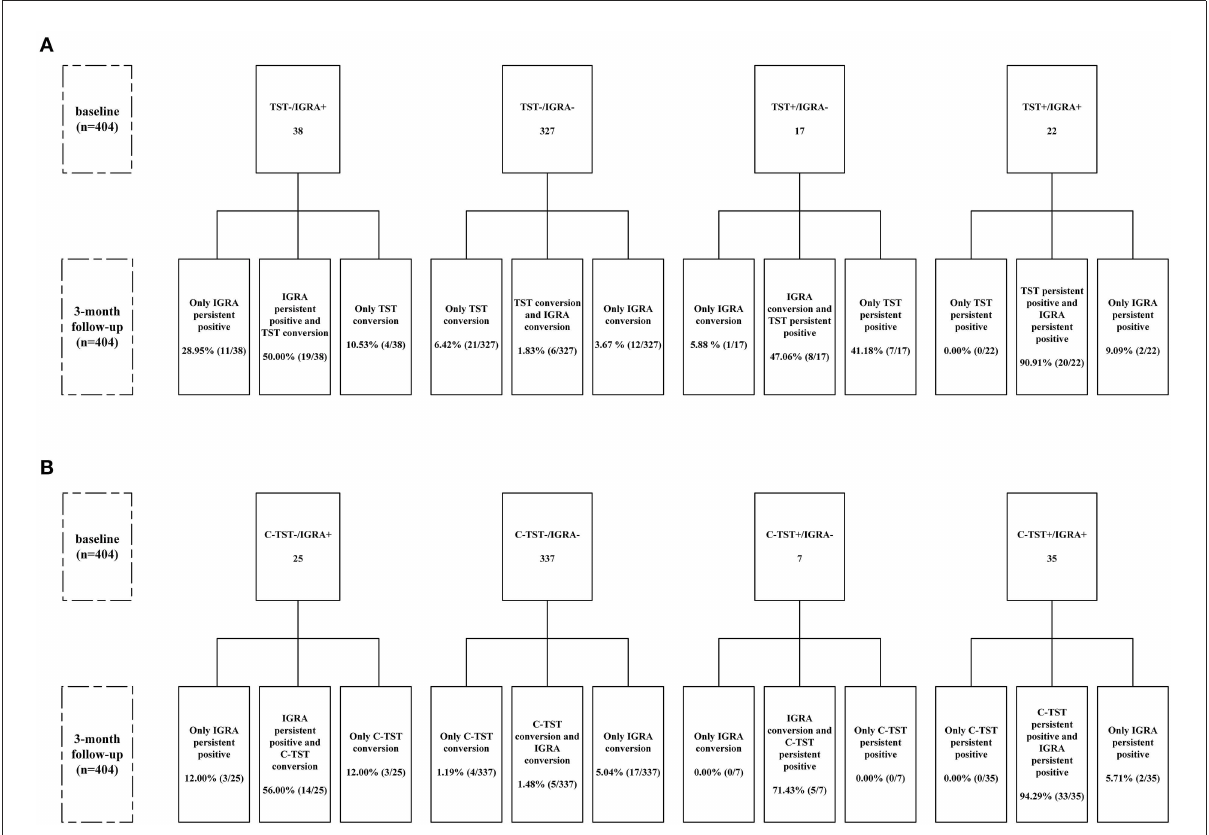
FIGURE1 Flow chart of serial testing of TST and C-TST according to IGRA results. (A) Stratified analysis according to baseline results of IGRA and TST (using cutoff value of 10mm); (B) Stratified analysis according to baseline results of IGRA and C-TST. C-TST, Creation tuberculin skin test; IGRA, Interferon-gamma release assay; TST, Tuberculin skin test. TST conversion was defined as the average diameter of induration ≥ 10mm for those with baseline survey < 5mm, or increased ≥ 10mm when the baseline survey result was between 5 and 10mm. C-TST conversion was defined as the average diameter of induration and erythema increased from < 5mm at baseline survey to induration or erythema ≥ 5mm at follow-up survey. IGRA conversion was defined as the IFN- γ releasing level of TB antigen-Nil (TBAg-Nil) increased from < 0.35 IU/ml at baseline survey to ≥ 0.35 IU/ml at follow-up survey. Persistent positive was defined as both positive for baseline and follow-up surveys according to the baseline positivity cutoff value.